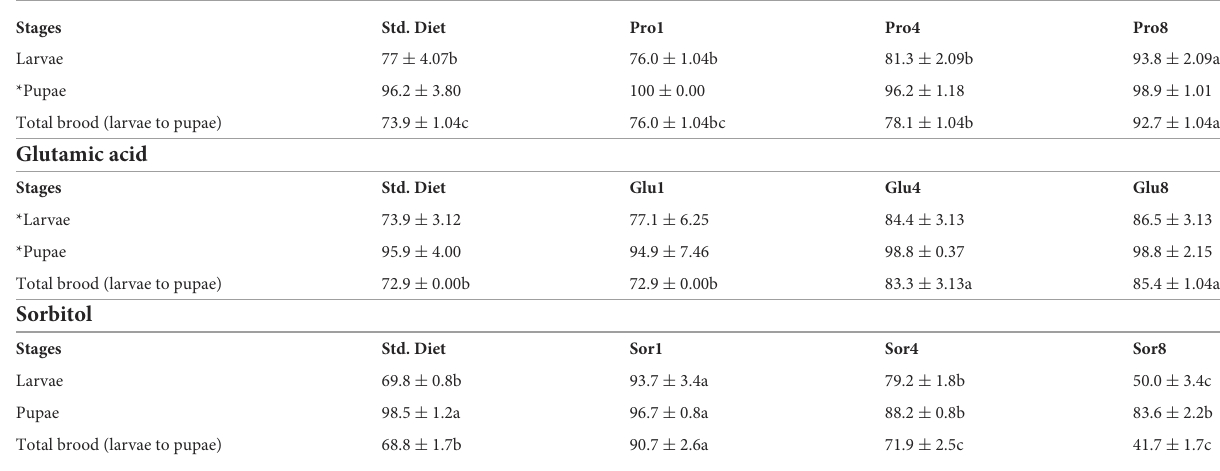
TABLE 3 The effects of different concentrations of proline, glutamic acid, and sorbitol (1, 4, and 8%) supplementation on the survival of bee brood (% ± S.E) and standard diets fed to honey bee larvae.